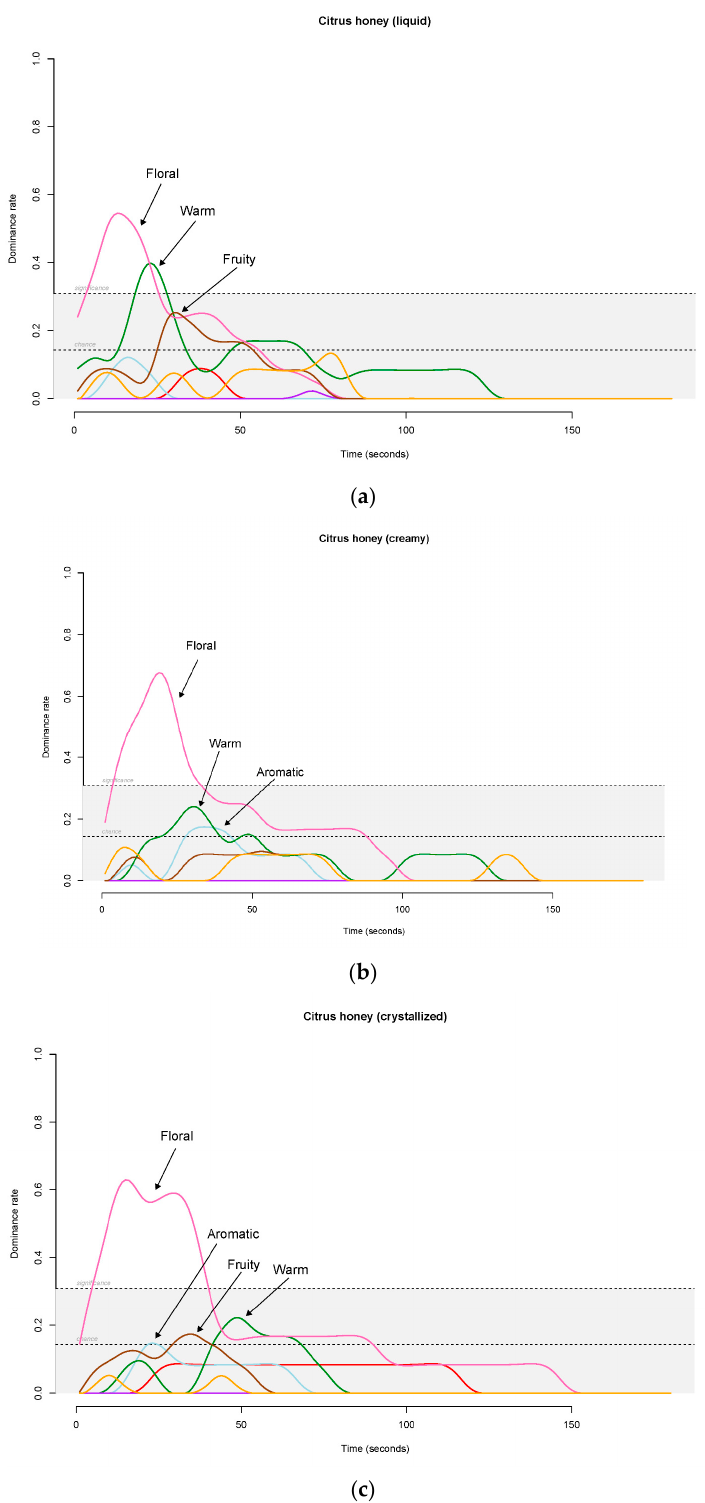
Figure 5. ( a ) TDS graphical representation for the liquid citrus honey. For each attribute, the spline regression plot displays the nonlinear regression function plotted through the original data. ( b ) TDS graphical representation for the creamy citrus honey. For each attribute, the spline regression plot displays the nonlinear regression function plotted through the original data. ( c ) TDS graphical representation for the crystallized citrus honey. For each attribute, the spline regression plot displays the nonlinear regression function plotted through the original